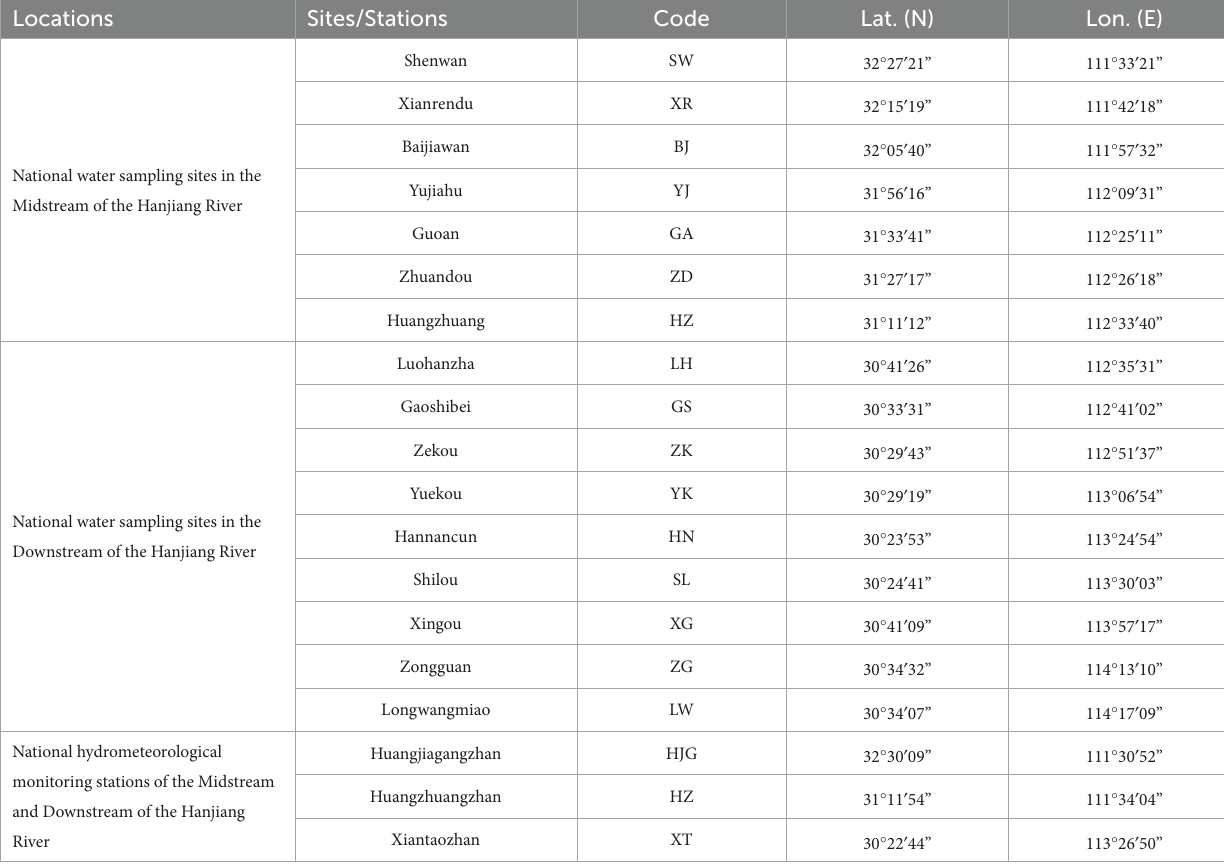
TABLE 1 Geographic coordinates and locations the water quality sampling sites and hydrometeorological monitoring stations in midstream and downstream of the Hanjiang River.